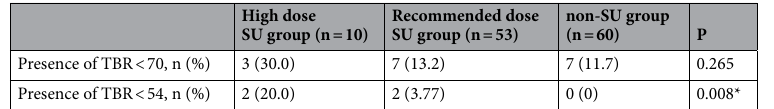
Recommended dose SU group (n = 53)